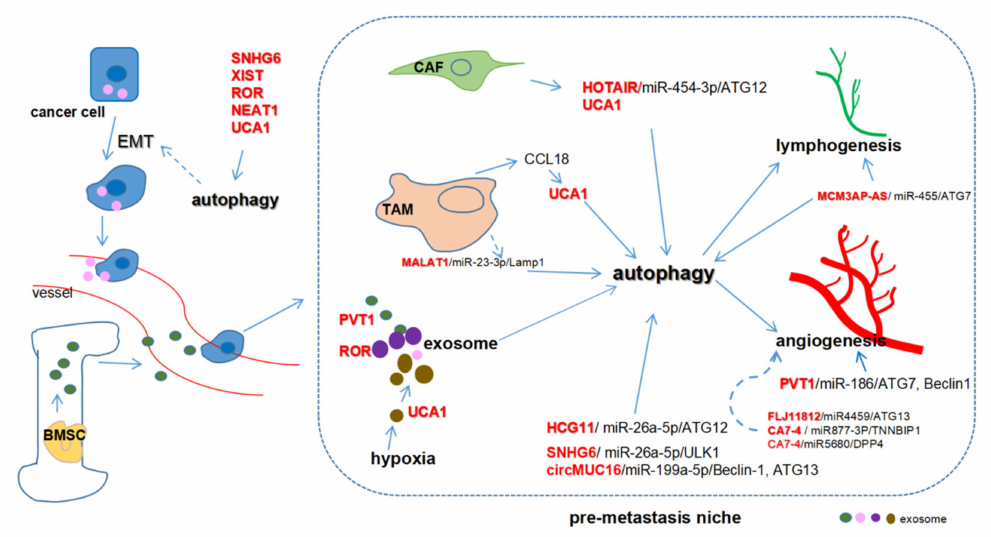
Figure 3. Competing endogenous RNAs (ceRNAs) regulate metastasis through autophagy. Cancer-associated fibroblasts (CAFs) increase HOTAIR and UCA1 expression while tumor-associated macrophages (TAMs) upregulate UCA1 through CCL18. MALAT1 / miR-23-3p regulates autophagy in macrophages. MCM3AP-ASinduces lymphatic vessel formation while PVT1 promotes angiogenesis by sponging miR-186. FLJ11812- and CA7-4-mediated autophagy may be essential for angiogenesis. PVT1, ROR, and UCA1 can be packaged in exosomes to promote metastasis. PVT1 can be encapsulated in exosomes derived from bone marrow mesenchymal stem cells (BMSC) while exosomal UCA1 is induced substantially by